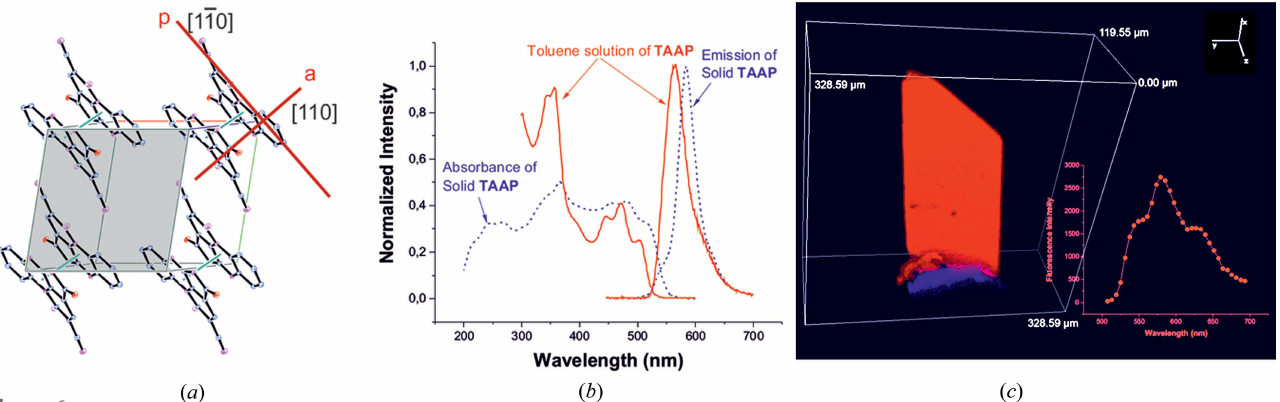
Figure 6 ( a ) View of the TAAP crystal structure at RT projected onto the (001) plane, parallel to the largest face of the crystal used for the fluorescence experiment (H atoms and phenyl rings at C3 and C5 have been omitted for clarity and displacement ellipsoids are drawn at the 30% probability level). The maximum fluorescence was observed with the analyzer approximately along [110]; the distances between gravity centres of molecules in the dimer (3.495 A˚ for TAAP_RTand 3.417 A˚ for TAAP_LT) are shown as turquoise lines. The orientation of the polarizers (compare with Fig. 5), approximately along [1 10] and [110], are marked by red lines. ( b ) Normalized absorption and fluorescence spectra for the solution of TAAP in toluene (solid line) and for the TAAP polycrystalline sample (double-dashed line). ( c ) The fluorescence three-dimensional image of the TAAP single crystal ( (cid:5) ex = 405 nm). Inset: fluorescence spectrum for a TAAP single crystal ( (cid:5) ex = 405 nm).